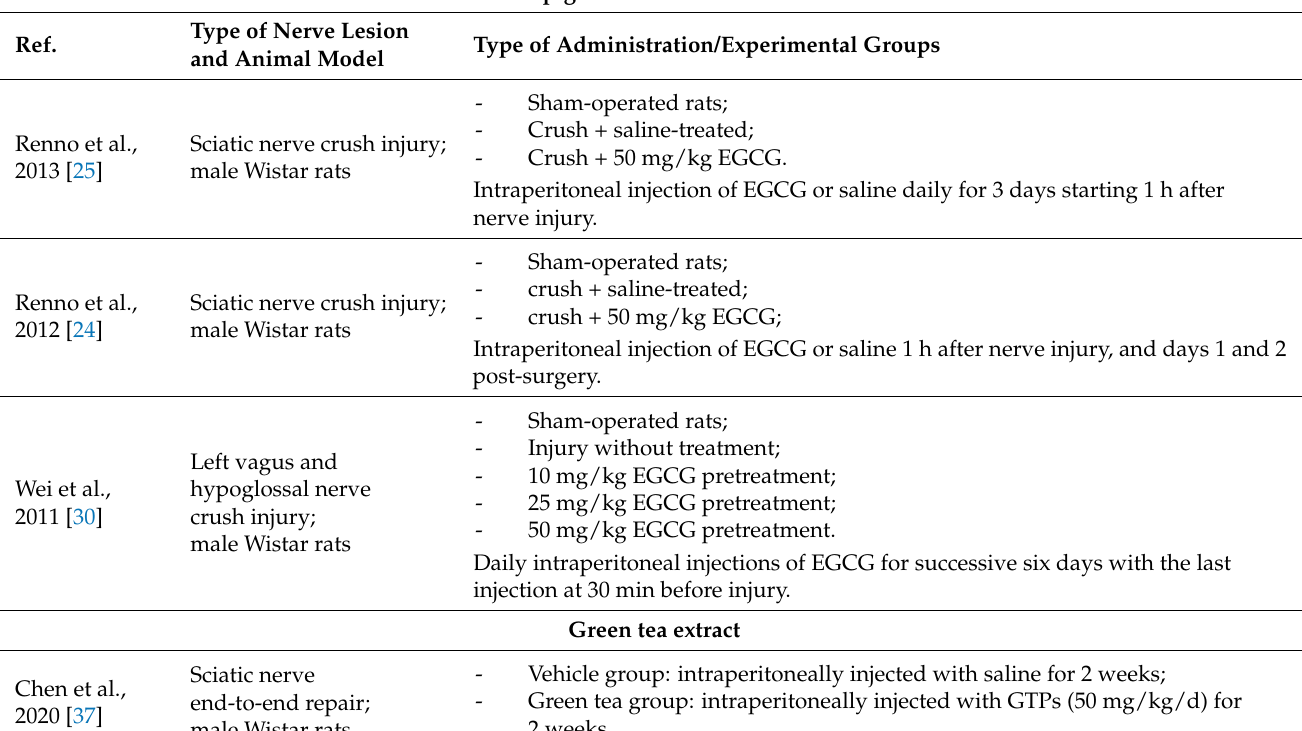
Epigallocatechin